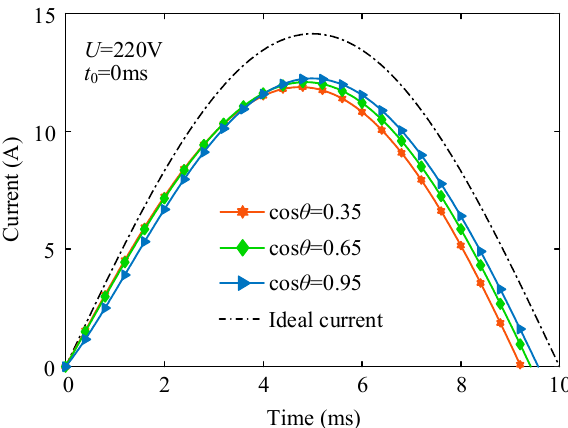
Figure 6. Arc current waveform under different power factors.